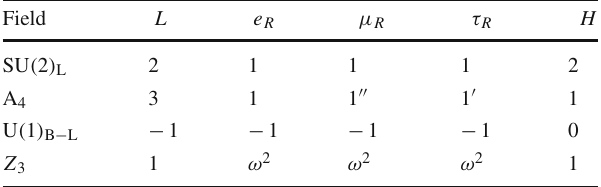
Table 1 SM field content of lepton and Higgs sectors alongwith their corresponding charges Field L